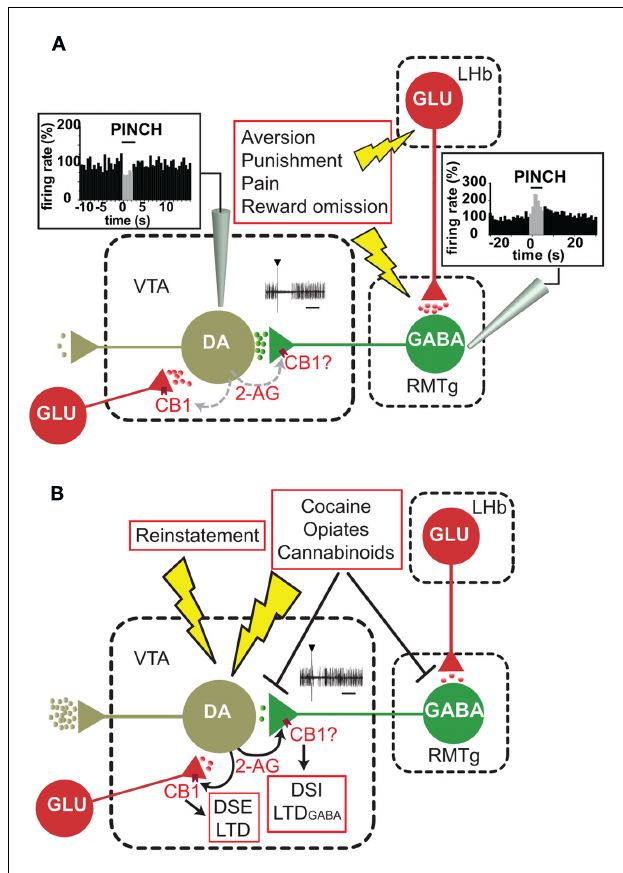
FIGURE 1 |The rostromedial tegmental nucleus (RMTg)–VTA pathway in aversion and reward mechanisms: possible role of endocannabinoids. (A) γ -Aminobutyric (GABA) neurons in the RMTg receive a major glutamatergic (GLU) input from lateral habenula (LHb), show phasic activation after aversive stimuli and inhibit ventral tegmental area (VTA) dopamine (DA) neurons.The inset displays oscilloscope traces recorded from a DA neuron inhibited for ∼ 100ms following RMTg stimulation.The graphs represent rate histograms recorded from RMTg and DA neurons and show increase or decrease in firing rate, respectively, following a painful stimulus (paw pinch). Rate histograms and oscilloscope traces are adapted from Lecca et al. (2011a,b).We hypothesize that pauses in DA neuron firing rate, which are known to encode reward omission and punishment, might be mediated by the RMTg and regulated by endocannabinoids (i.e., 2-arachidonoylglycerol, 2-AG) activating presynaptic CB1 receptors. DA neurons receive also important glutamatergic afferents arising from various brain regions. Glutamatergic terminals are also endowed with presynaptic CB1 receptors. (B) Acute drug administration or reinstatement of drug self-administration excite DA neurons and DA release in terminal regions. On the other hand, addicting drugs also inhibit RMTg neurons (Lecca et al., 2011a) and/or suppress RMTg-induced inhibition of DA neurons (Lecca et al., 2011b), contributing to their excitation via a disinhibition mechanism.The oscilloscope traces in the inset show that RMTg-induced inhibition of the same DA neuron as in (A) is attenuated following cannabinoid administration (from Lecca et al., 2011b). Hence, we hypothesize that endocannabinoids might modulate the strength of these inhibitory afferents via long- or short-term forms of synaptic plasticity (such as depolarization-induced suppression of inhibition, DSI or long-term depression of GABA afferents, LTD GABA , respectively).The picture is further complicated, however, by the fact that endocannabinoids also modulate glutamatergic afferents, inducing functionally opposite forms of synaptic plasticity (such as depolarization-induced suppression of excitation, DSE or long-term depression of glutamatergic afferents,